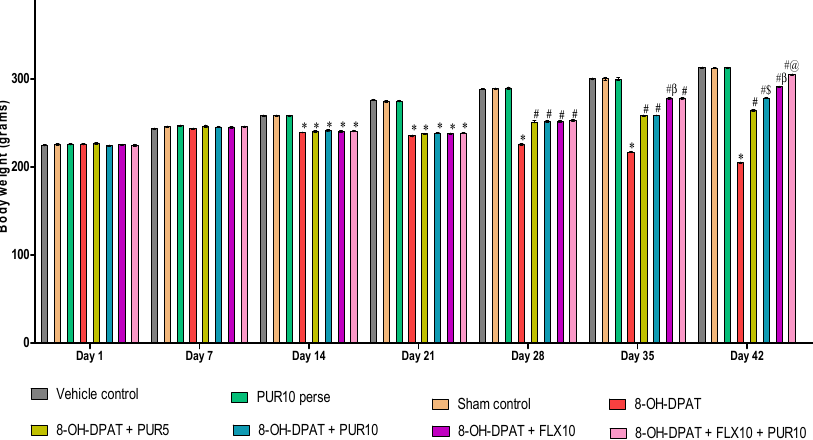
Figure 2. Effect of purmorphamine on body weight in 8-OH OCD. Statistical analysis followed by two-way ANOVA (post-hoc Bonferroni’s test). Values expressed as mean ± SEM ( n = 6 rats per group). * p < 0.01 v/s vehicle control, sham control and PUR10 per se; # p < 0.01 v/s 8-OH-DPAT; #$ p < 0.01 v/s 8-OH-DPAT + PUR5; # β p < 0.01 v/s 8-OH-DPAT + PUR5 and 8-OH-DPAT + PUR10; #@ p < 0.01 v/s 8-OH-DPAT + FLX10.